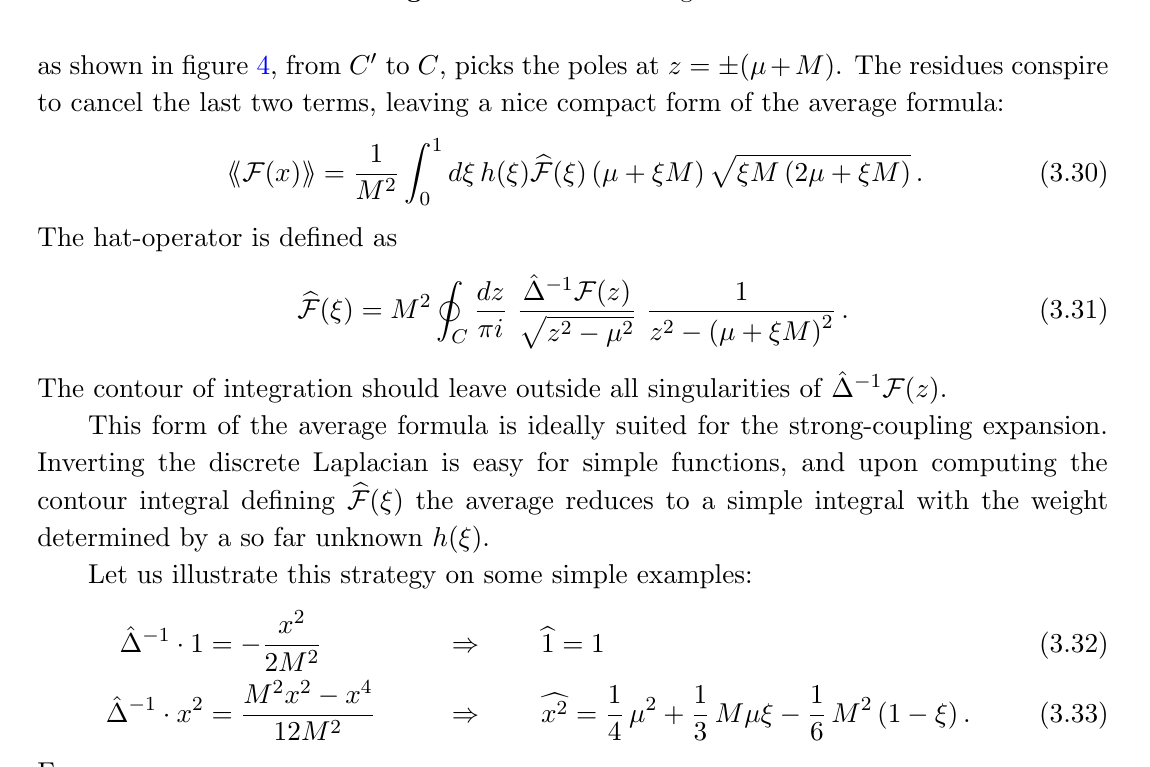
Figure 4 . Contours of